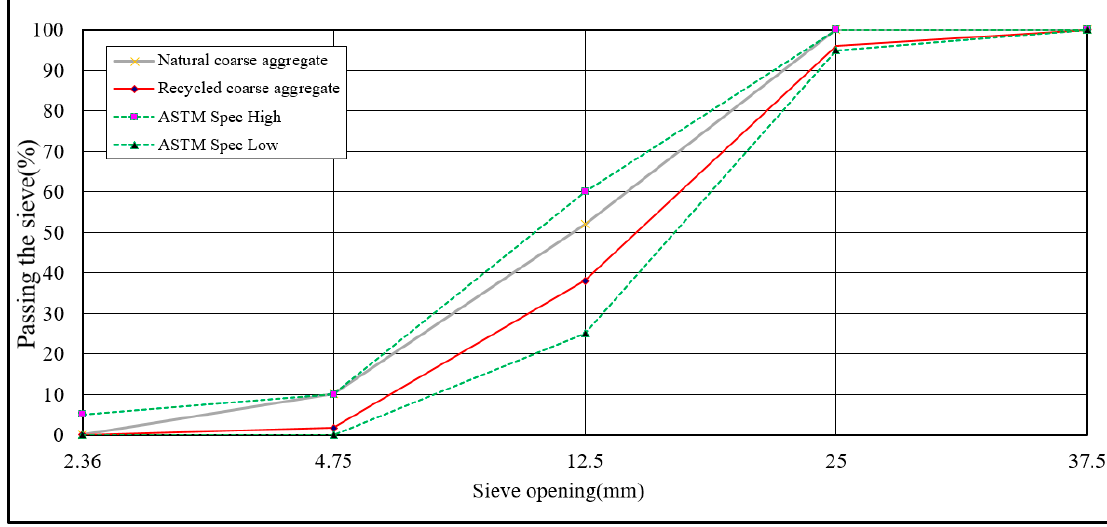
Figure 4. Particle size distribution curve of natural and recycled coarse aggregate.